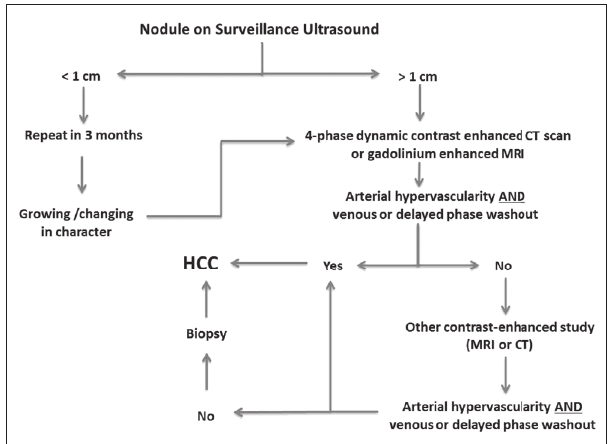
Figure 2) Algorithm for the diagnosis of hepatocellular carcinoma (HCC) after identification of a lesion on a surveillance ultrasound. CT Computed tomography; MRI Magnetic resonance imaging. Adapted with permission from reference